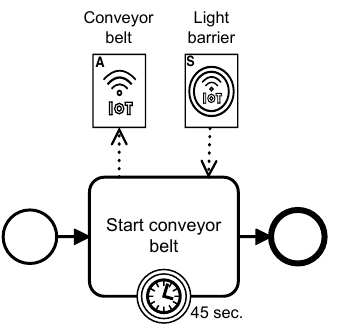
Figure 8. Usage of Catch Artifact and Actuator Artifact.